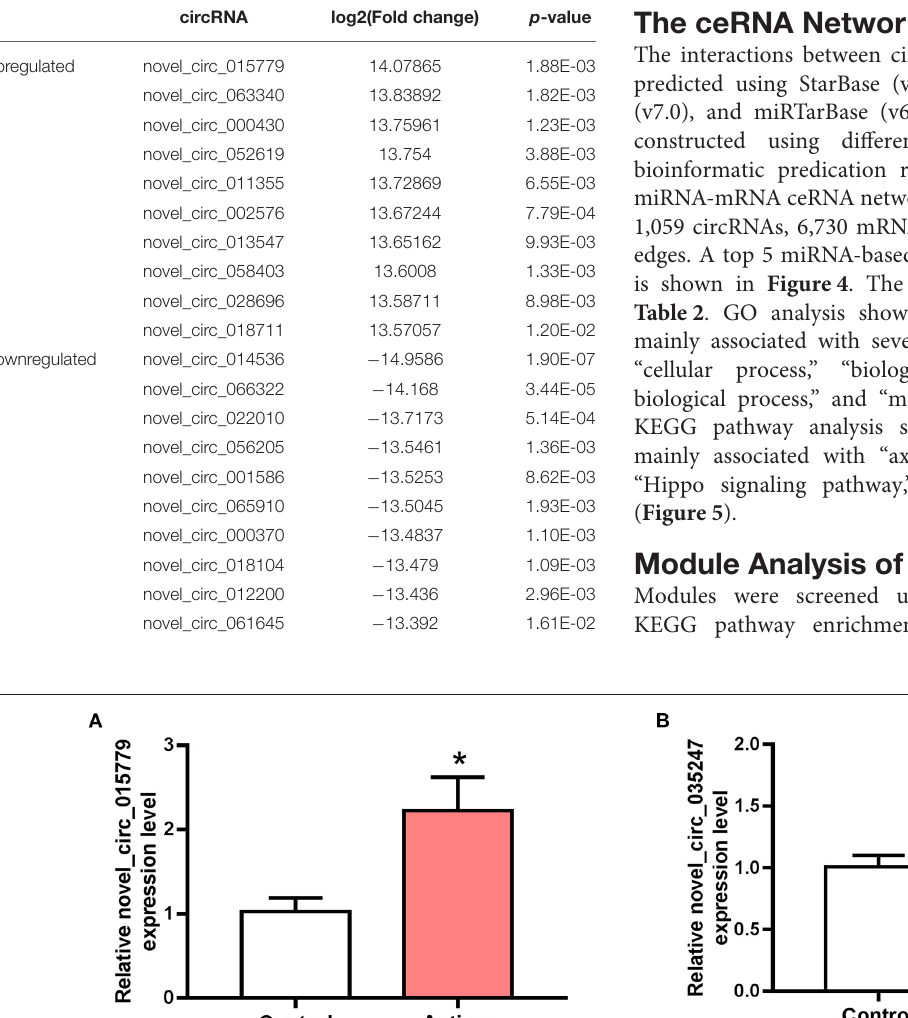
Frontiers in Genetics |